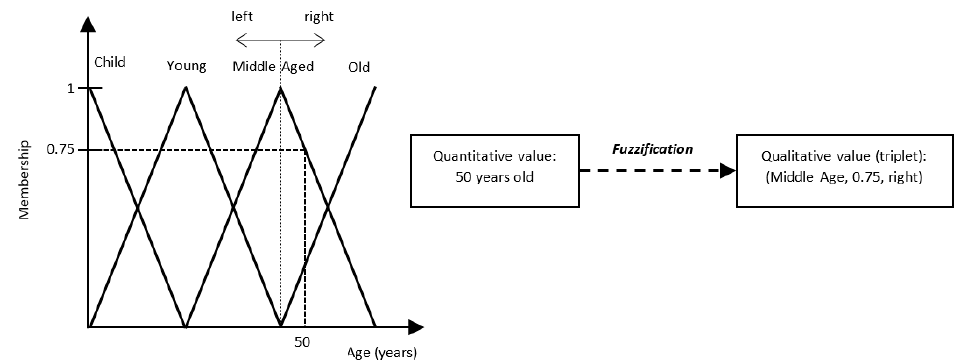
Figure 1. Fuzzy inductive reasoning (FIR) fuzzification process of human age variable.